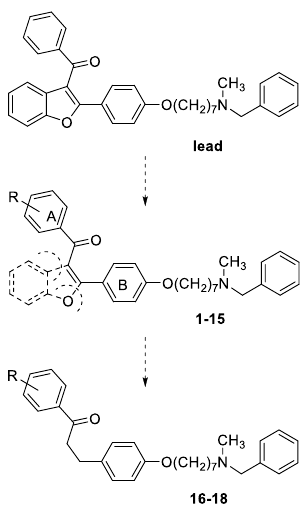
Figure 1. Design strategy for the studied compounds 1 – 18 .